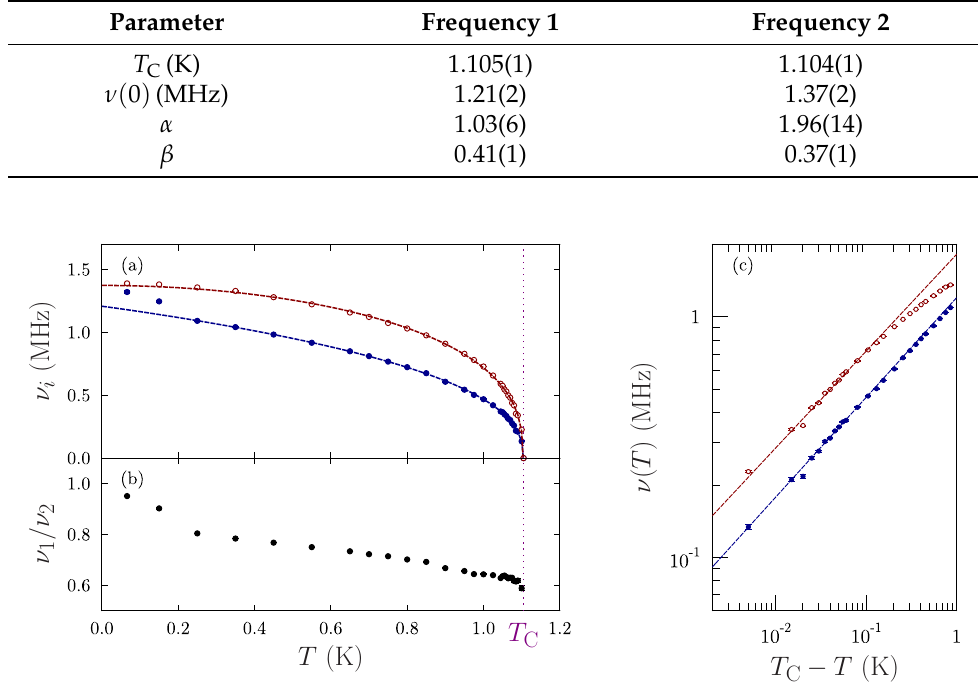
Figure 3. ( a ) Temperature evolution of the precession frequencies of the µ SR spectra in DNPNN for T < T C from fits to Equation (1). ( b ) The ratio of the frequencies ν 1 and ν 2 . ( c ) A scaling plot of the frequencies ν 1 and ν 2 in the critical